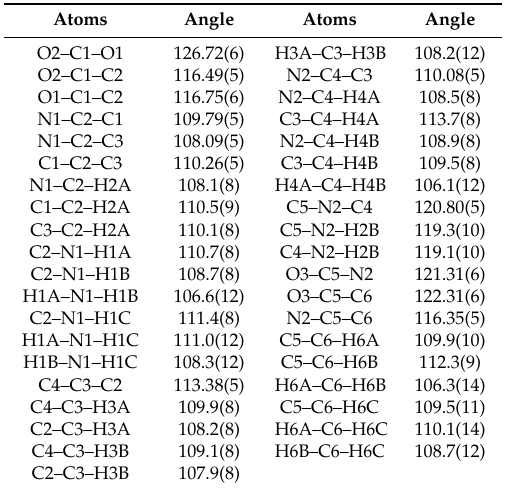
Table 3. Bond angles for γ -NADA at 100 K, angles in ◦ .